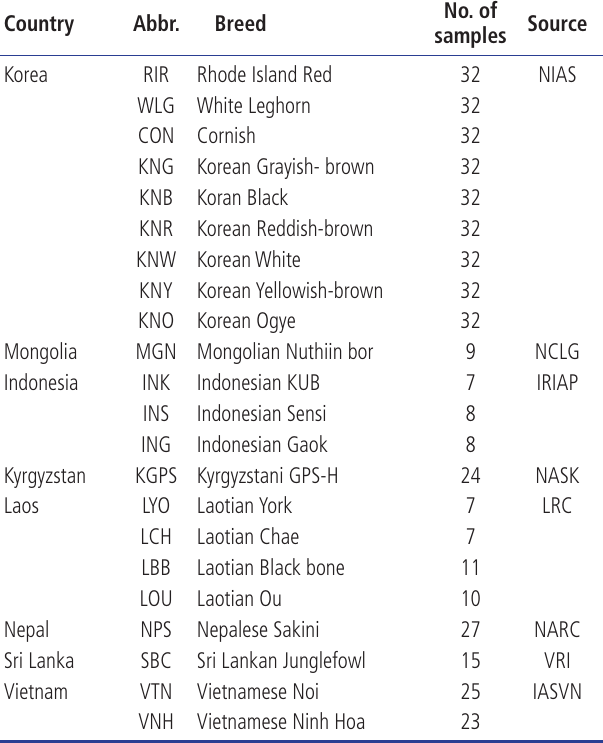
Table 1. Description of the 22 chicken breeds used in this study